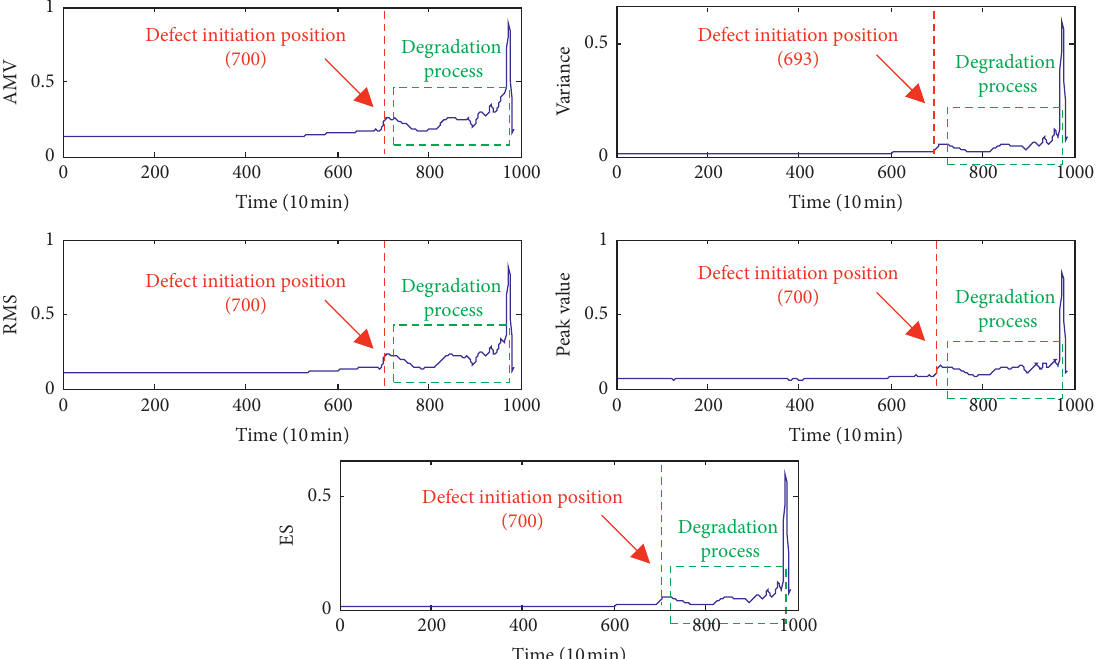
Figure 12: Characteristic parameters after multiscale decomposition.